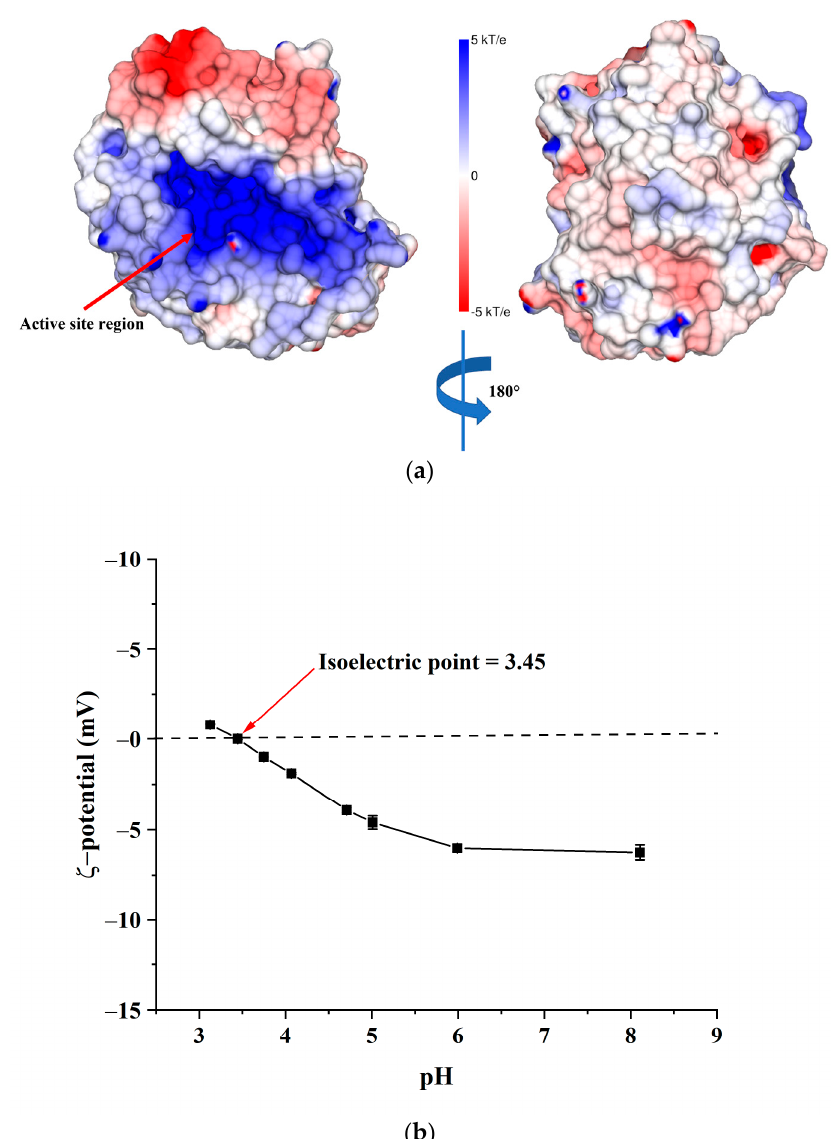
Figure 5. Distribution of electrostatic potential on the molecular surface of AlgL protein (PDB:4OZV) [48] ( a ). The potential was [49] calculated according to the predicted by using the PROPKA server the pK values of titratable amino acid. The electrostatic potential was calculated with the assumption of environment pH 7.4 using an APBS solver via a PDB2PQR server. The results of the calculation were analysed with the UCSF Chimera 1.13.1rc package [50]. The ζ -potential of BC membranes depends on the pH of the solution ( b ).